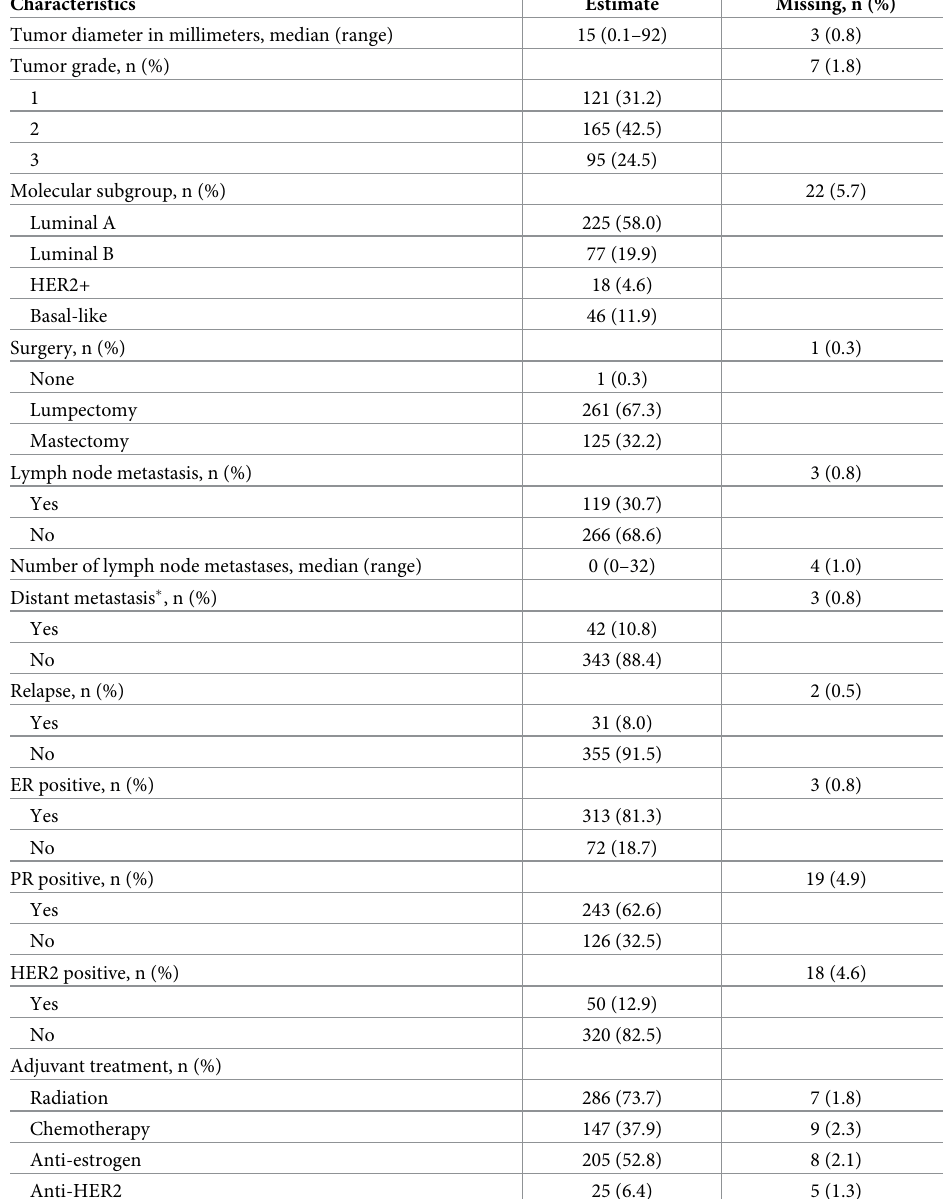
Table 3. Clinical characteristics of the participants in the CAMO cohort (n = 388).